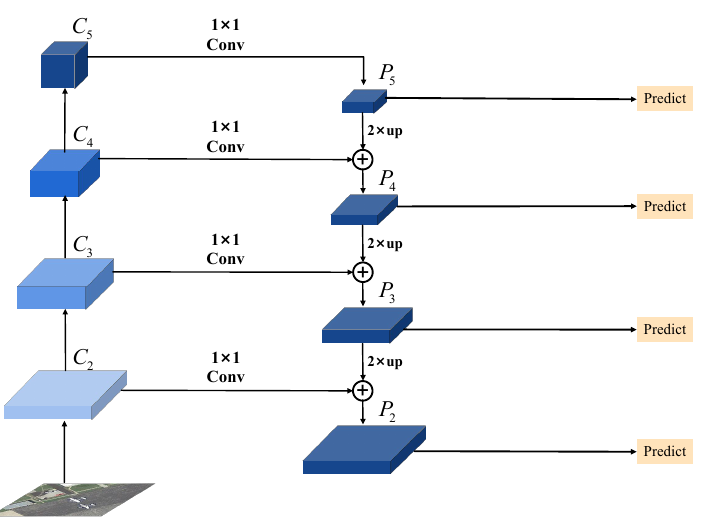
Figure 1. Flowchart of